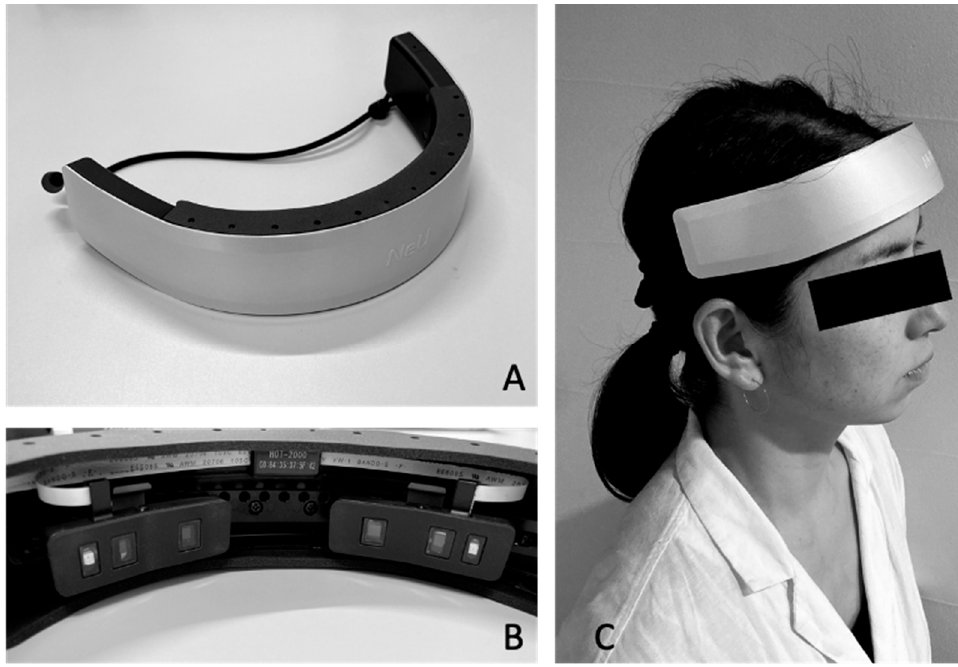
Figure 1. Photographs of the device used to measure brain activity (HOT-2000). ( A ) overall device view. ( B ) Close-up view of the sensor units. ( C ) Photograph of a subject wearing the device.